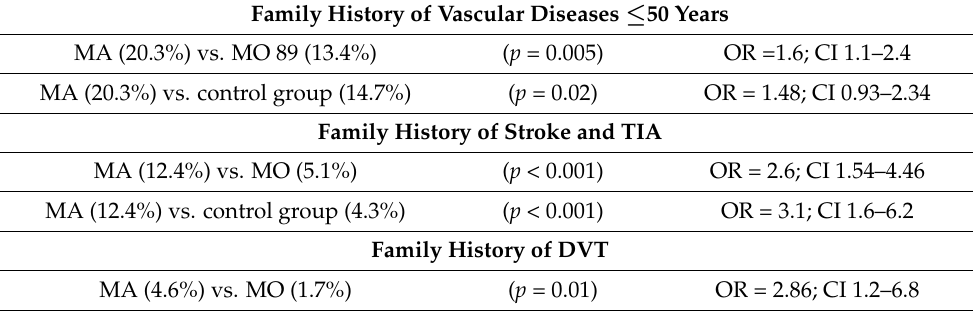
Table 3. Family history of major thrombotic events at ≤ 50 years old in children with MA and MO and children in the control